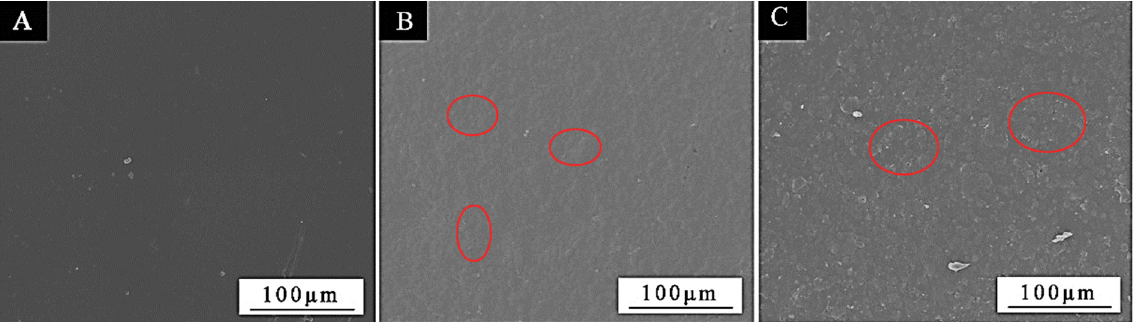
Figure 10. Morphology of the coatings with the addition of different microcapsule loadings on wood surface: ( A ) 0%, ( B ) 15.0%, ( C ) 20.0%.